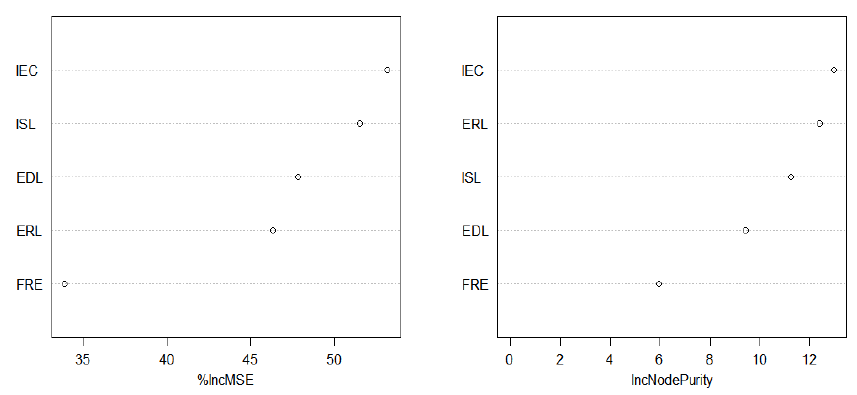
Table 5. Analysis results of IncMSE and IncNodePurity.